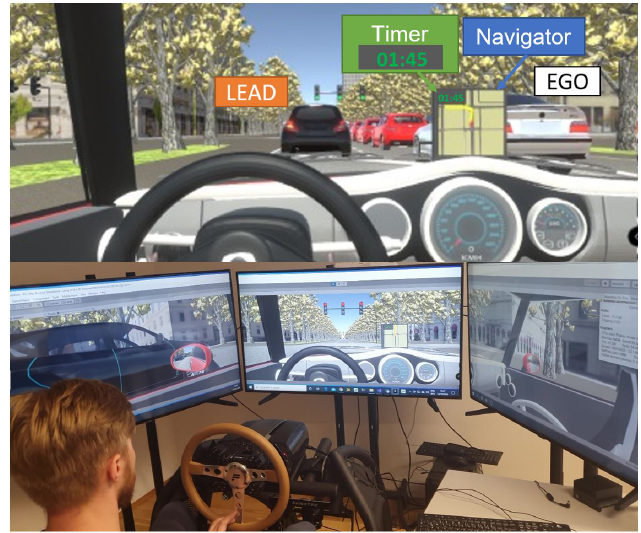
Figure 9. The 3DCoAutoSim simulation platform during a driving test and a screenshot of the scenario setup and in-vehicle systems.